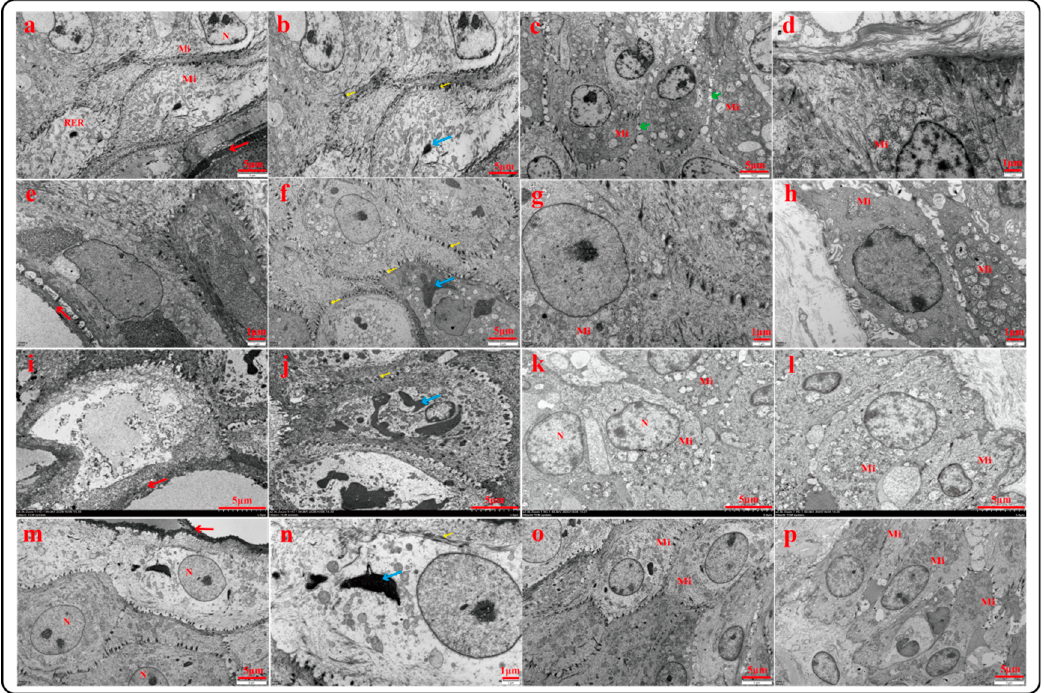
Figure 3. Ultrastructure of rumen epithelium of Tibetan sheep at different ages: 4 months ( a – d ); 1.5 years ( e – h ); 3.5 years ( i – l ); 6 years ( m – p ); nucleus (N), mitochondria (Mi), stratum corneum ( ↓ ), keratin granules ( ↓ ), desmosomal junctions ( ↓ ), intercellular space ( ↓ ).